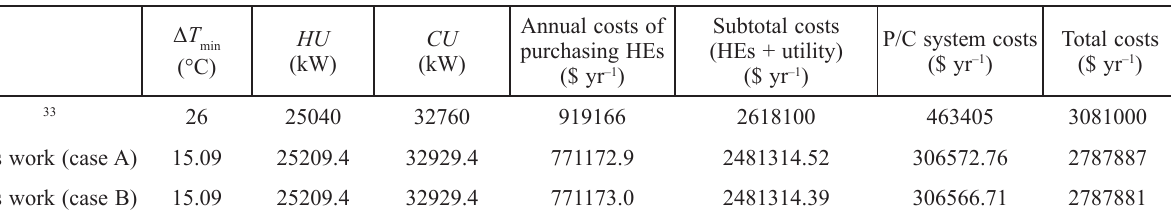
Table 4 – Comparison of the results for case study one